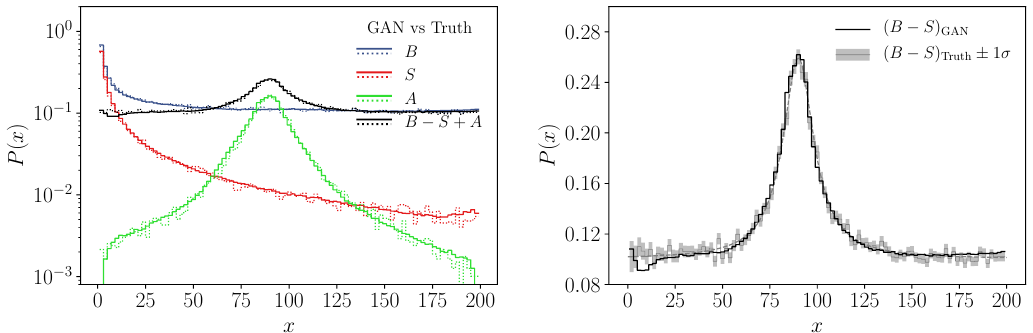
Figure 3: Left: Generated (solid) and true (dotted) events for the three input distri- butions and the combined output. Right: distribution of the combined events, true and generated, including the error envelope propagated from the input